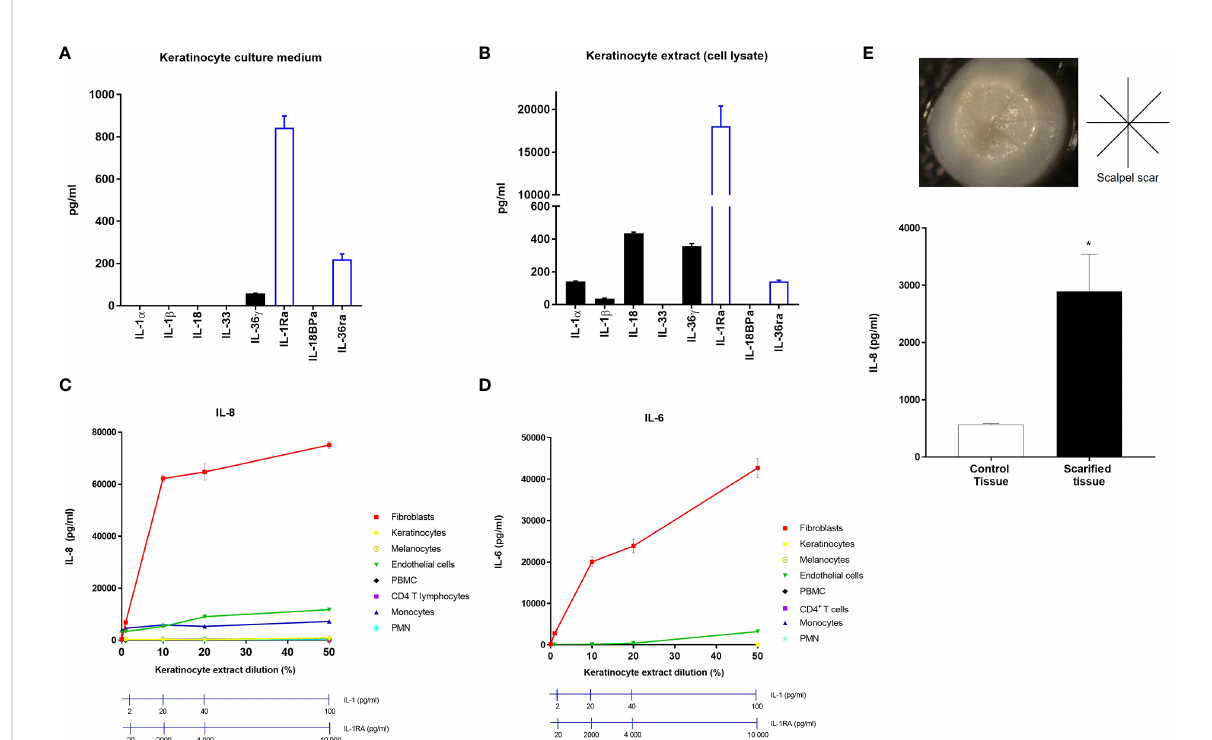
FIGURE 2 Dermal fi broblasts are stimulated by keratinocyte extracts. Concentrations of the IL-1 family members, IL-1 a , IL-1 b , IL-18, IL-33, IL-36 g , IL-1RA, IL-18BP and IL-36RA were measured by ELISA in culture medium of keratinocytes cultivated in healthy conditions (A) or in keratinocyte extracts after cell lysis (B) . Several cell types including fi broblasts, keratinocytes, melanocytes, endothelial cells, PBMC, CD4 T cells, monocytes and PMN were stimulated with different dilutions of keratinocyte extracts. IL-8 (C) and IL-6 (D) concentrations were measured by ELISA in culture medium of stimulated fi broblasts. Concentrations of IL-1 and IL-1RA were measured for each keratinocyte extract dilution and were indicated above (C, D) . Reconstituted human skins were scari fi ed with a scalpel under sterile conditions according to the indicated cross-shaped scheme (E) . Scars are observable on the representative image of the reconstituted human skin. IL-8 concentrations were measured in the underlying culture medium, 48 h after scari fi cation or in non-lesioned control tissue. Data are representative of three independent experiments done in triplicate. * P < 0.05, using the Mann & Whitney ’ s test for comparison between